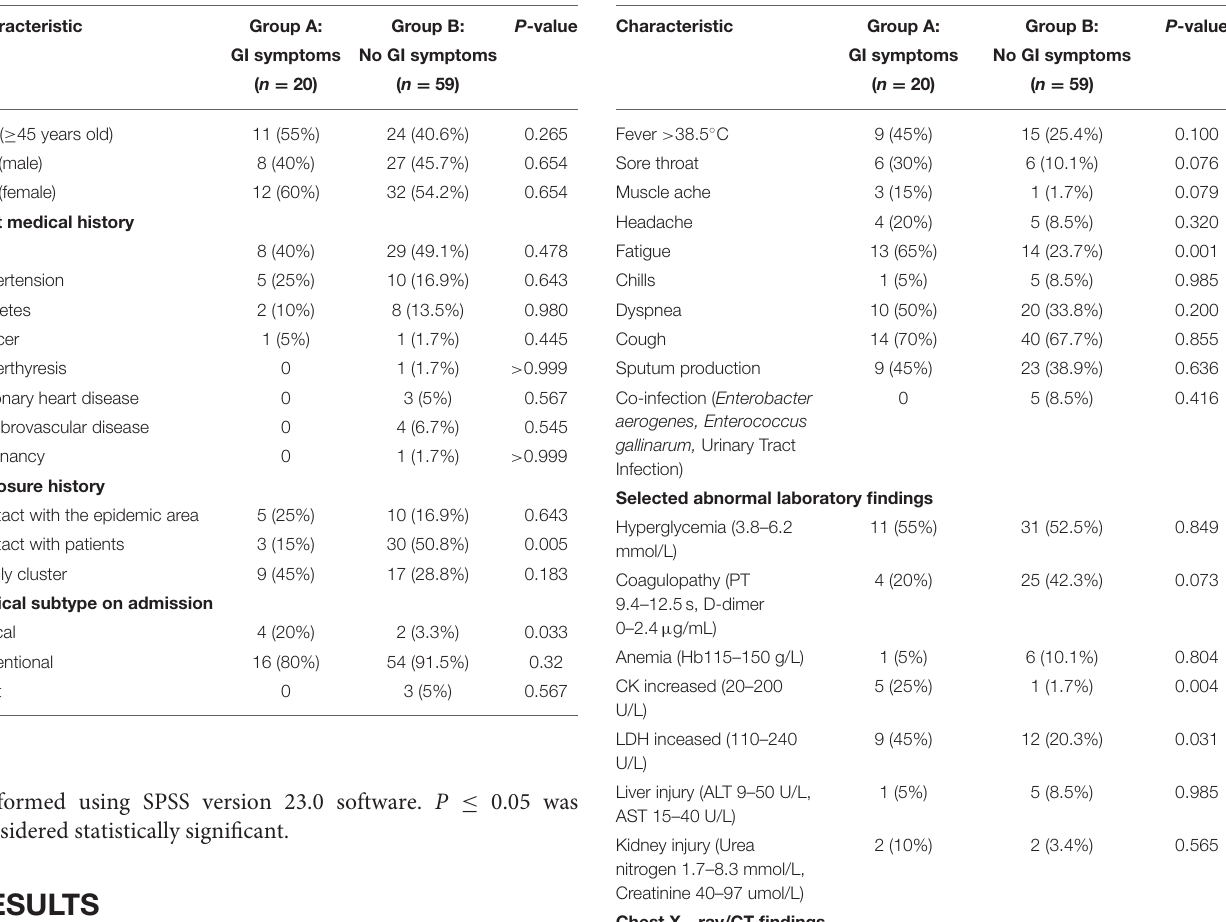
TABLE 1 | Epidemiological characteristics of patients with COVID-19 with and without GI symptoms. Characteristic Group A: Group B: P -value